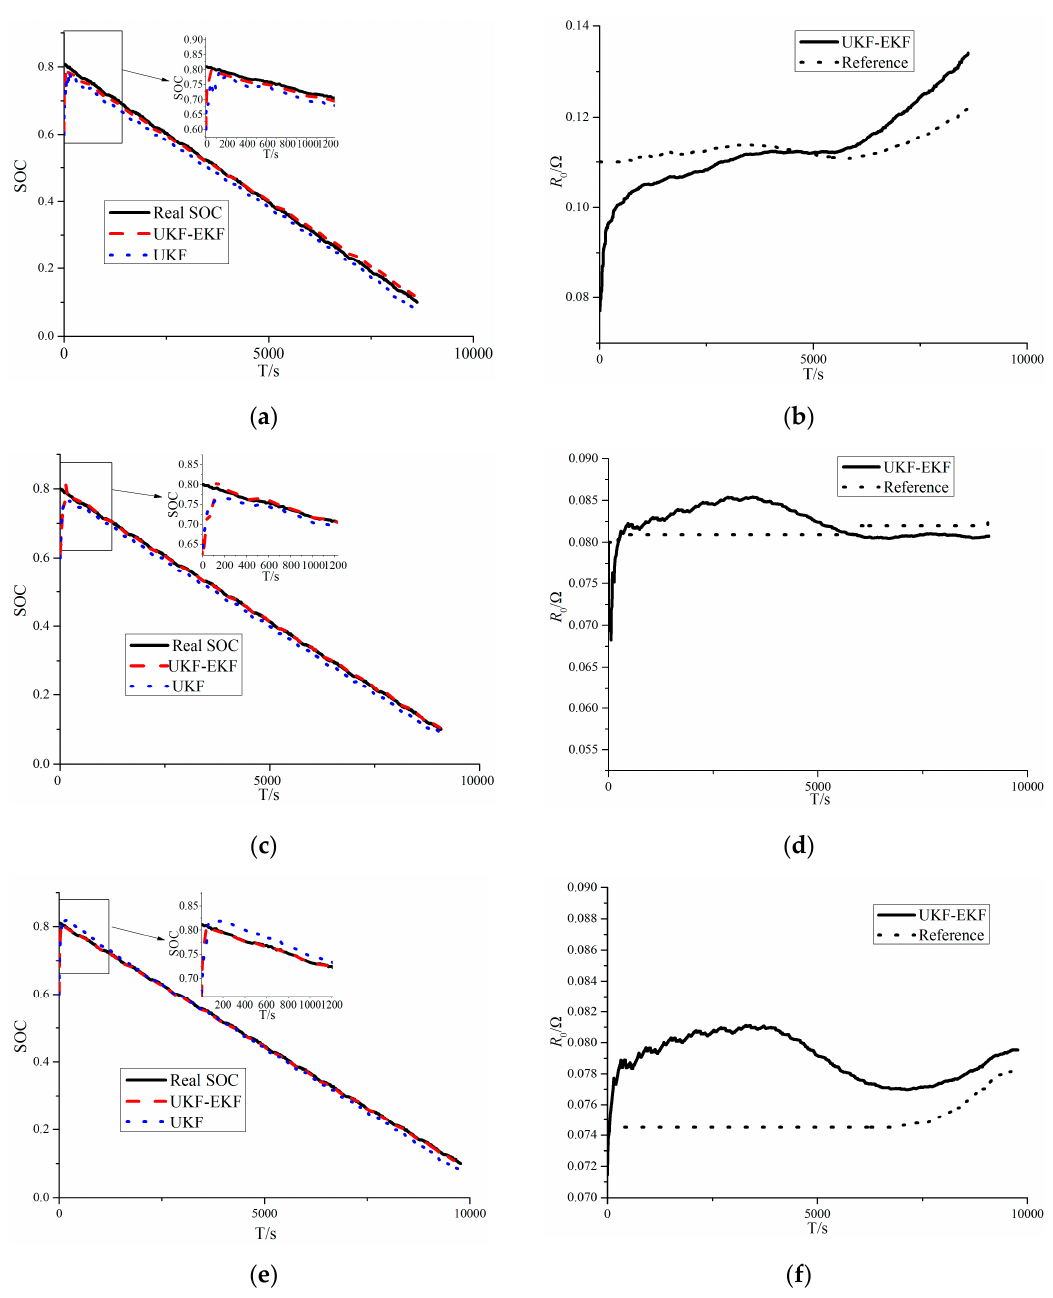
Figure 6. Results of the estimation of the SOC and ohmic resistance (R 0 ) in US06: ( a ) SOC comparison between the UKF–EKF and UKF at 0 °C; ( b ) R 0 identification of the UKF–EKF at 0 °C; ( c ) SOC comparison between the UKF–EKF and UKF at 25 °C; ( d ) R 0 identification of the UKF–EKF at 25 °C; ( e ) SOC comparison between the UKF–EKF and UKF at 45 °C; ( f ) R 0 identification of the UKF–EKF at 45 °C.